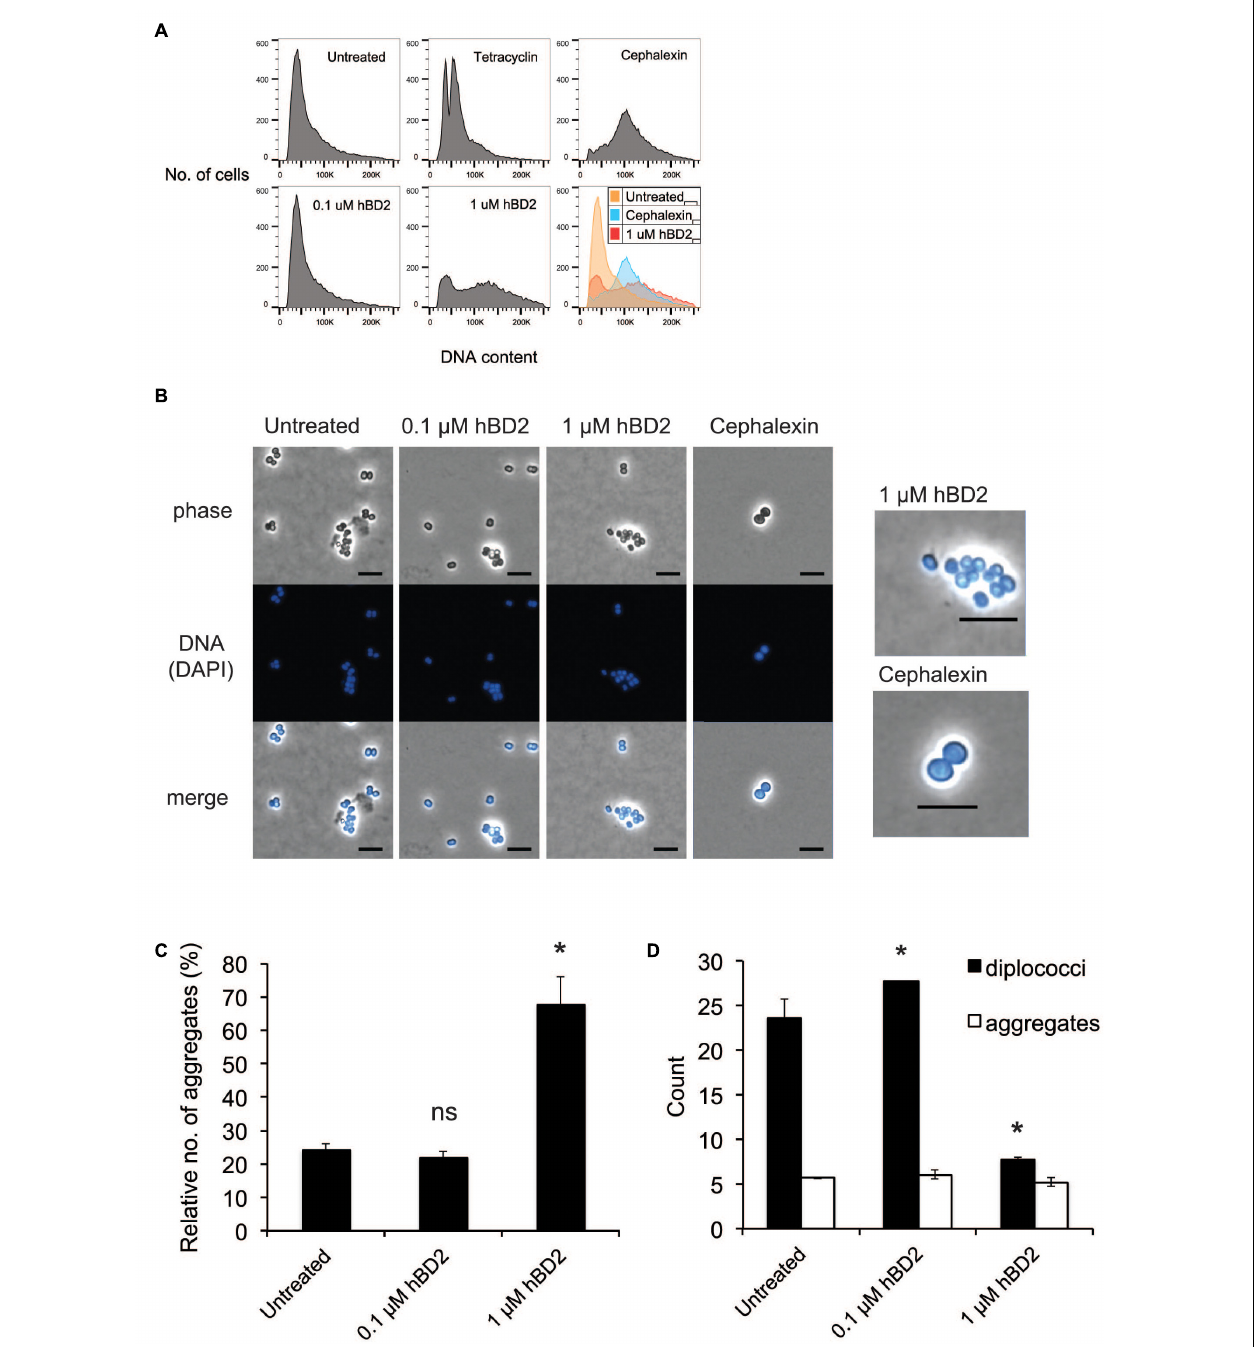
FIGURE 3 | Neisseria meningitidis diplococci are more susceptible to hBD2. (A) Flow cytometry analysis of N. meningitidis in the presence of hBD2. Log-phase bacteria were incubated with hBD2 (0.1 or 1 µ M), tetracycline (2 µ g/ml), or cephalexin (10 µ g/ml) for 2 h. Bacteria were washed in PBS, fixed, permeabilized, and resuspended in sodium citrate buffer. DNA was stained with SYTOX Green, and DNA content was analyzed by flow cytometry. The assay was performed in single samples three times. (B) Microscopy of N. meningitidis . Log-phase bacteria were incubated with hBD2 (0.1 or 1 µ M) or cephalexin (10 µ g/ml) for 2 h. Bacteria were washed in PBS once, fixed, permeabilized and resuspended in PBS. DNA was stained with DAPI, and bacteria were visualized by fluorescence microscopy. On the right side are enlarged images of indicated treatments. The scale bar represents 5 µ m. Representative images are shown. (C,D) Microscopy images were used to enumerate diplococci bacteria and bacteria in aggregates, where aggregates were defined as clusters of 4 or more cells. Counts are expressed as relative numbers of aggregates compared to diplococci (C) or as absolute numbers (D) . The assay was performed two times with at least 12 images captured per sample. Data are represented as the mean values, with error bars representing the standard deviation. Significance was tested against the untreated control. * P < 0.05; ns, non-significant.